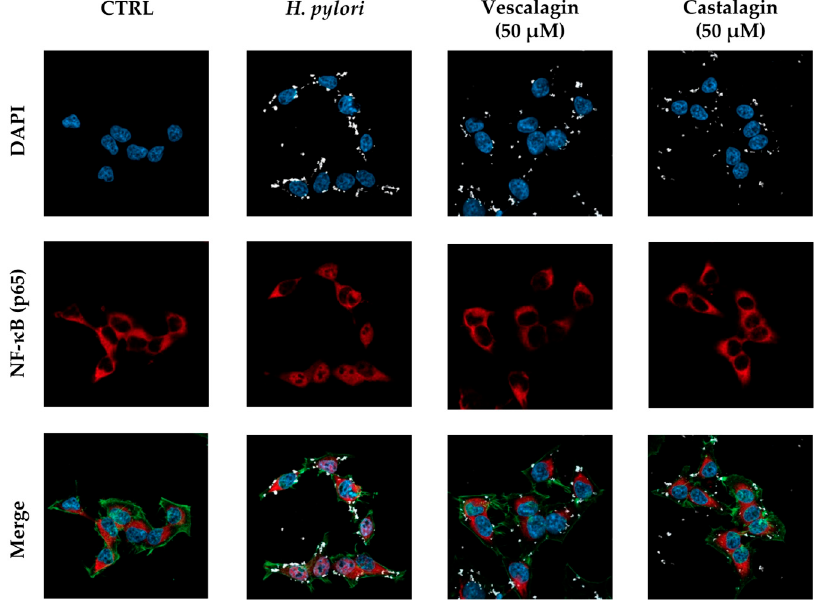
Figure 5. Effect of ellagitannins from Castanea sativa Mill. on NF- κ B (p65) nuclear translocation induced by H. pylori . GES-1 cells were treated for 1 h with H. pylori (ratio 50:1, bacteria/cell) in addition to the ellagitannin isomers castalagin and vescalagin (50 µM). NF- κ B (red) nuclear translocation from the cell cytoplasm into the nuclei (blue) was detected by confocal immunofluorescence microscopy (63× objective). Merged images include β -actin (green) and bacterial DNA (CFSE, white) staining. Cast., castalagin; Vesc., vescalagin.